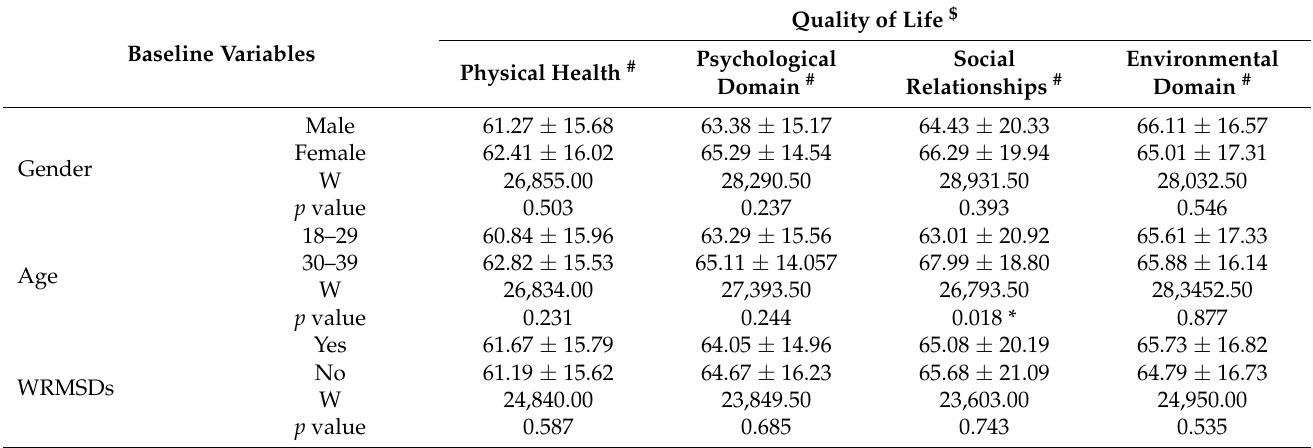
Table 3. Results of the QoL domains based on gender and musculoskeletal